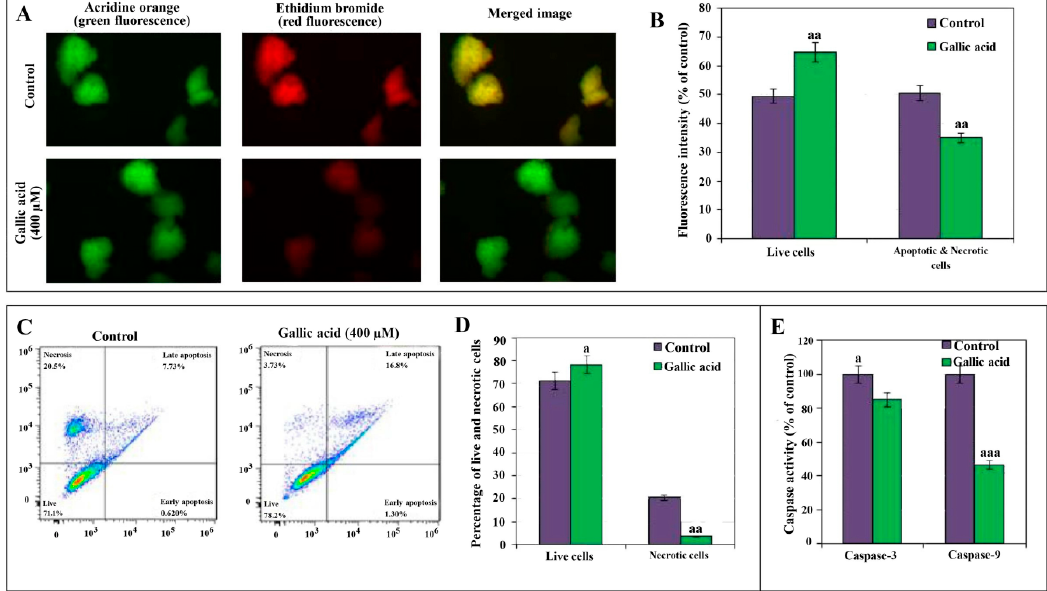
Figure 5. Apoptosis in pancreatic islet cells exposed to gallic acid (GA) demonstrated by Fluorescence microscopy images of cells (40 × magnification) stained with acridine orange (AO) and ethidium bromide (EB) after 400 µ M GA exposure. Pancreatic islet cells stained with acridine orange (green fluorescence), ethidium bromide (red fluorescence), and merged image (yellow / green fluorescence) ( A ). The percentage of viable, apoptotic, and necrotic cells from the staining data is also graphically shown ( B ). Contour diagrams of flow cytometry presents live, early / late apoptotic, and necrotic cells ( C ), and the percentage of live and necrotic cells from flow cytometry data is also graphically shown ( D ). E ff ect of 24 h exposure of 400 µ M GA on the level of caspase-3 / 9 activities is shown in the last graph ( E ). Data are presented as the mean ± standard error of measurements performed on six groups, with three independent replicates. Significant di ff erence from control ( a p < 0.05, aa p < 0.01 and aaa p <